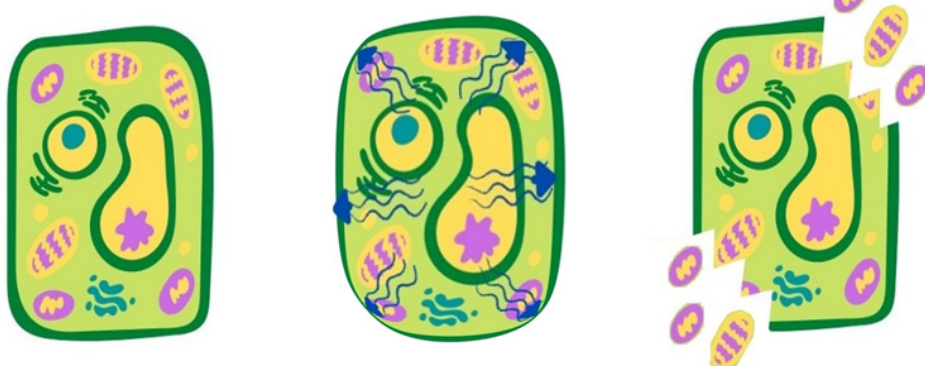
Figure 2. Mechanism of cell rupture induced by microwave: rapid increase of temperature and pressure inside the cell, cell break down and release of target molecules.